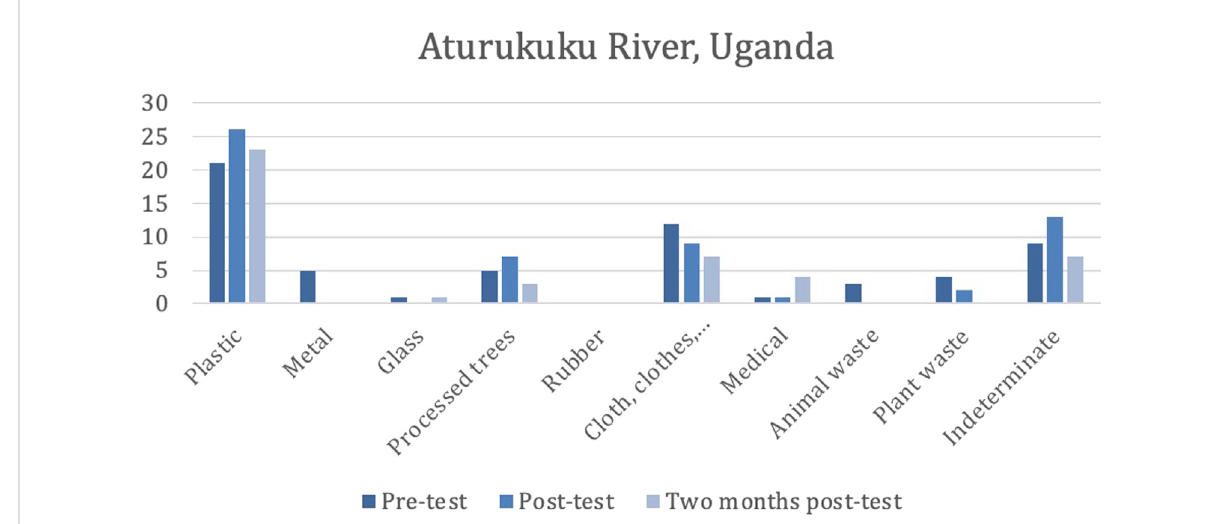
FIGURE 3 Participant perceptions of the most frequently found items in the Aturukuku River by type.